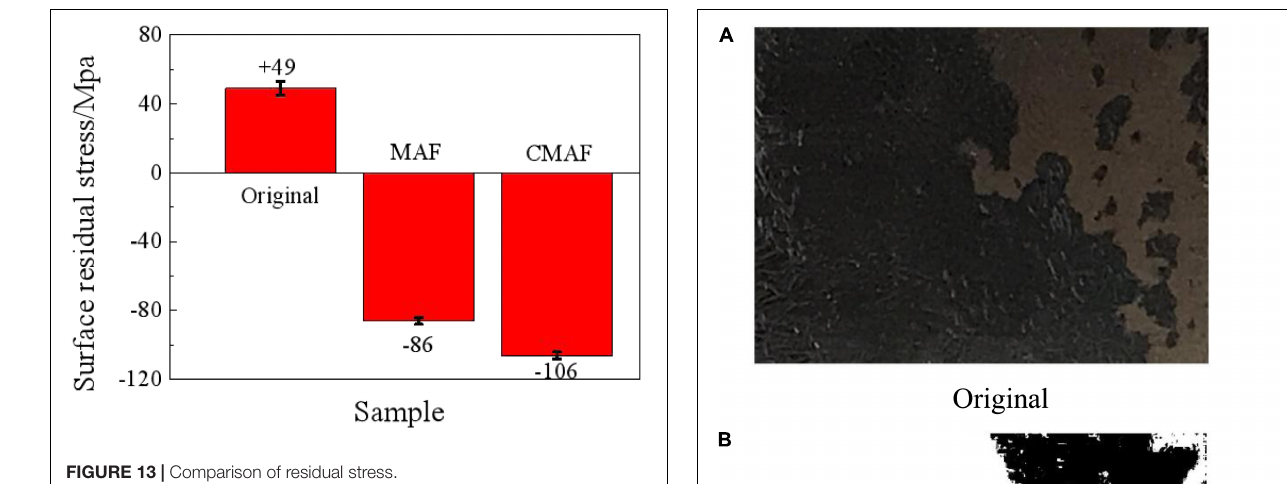
FIGURE 13 | Comparison of residual stress.